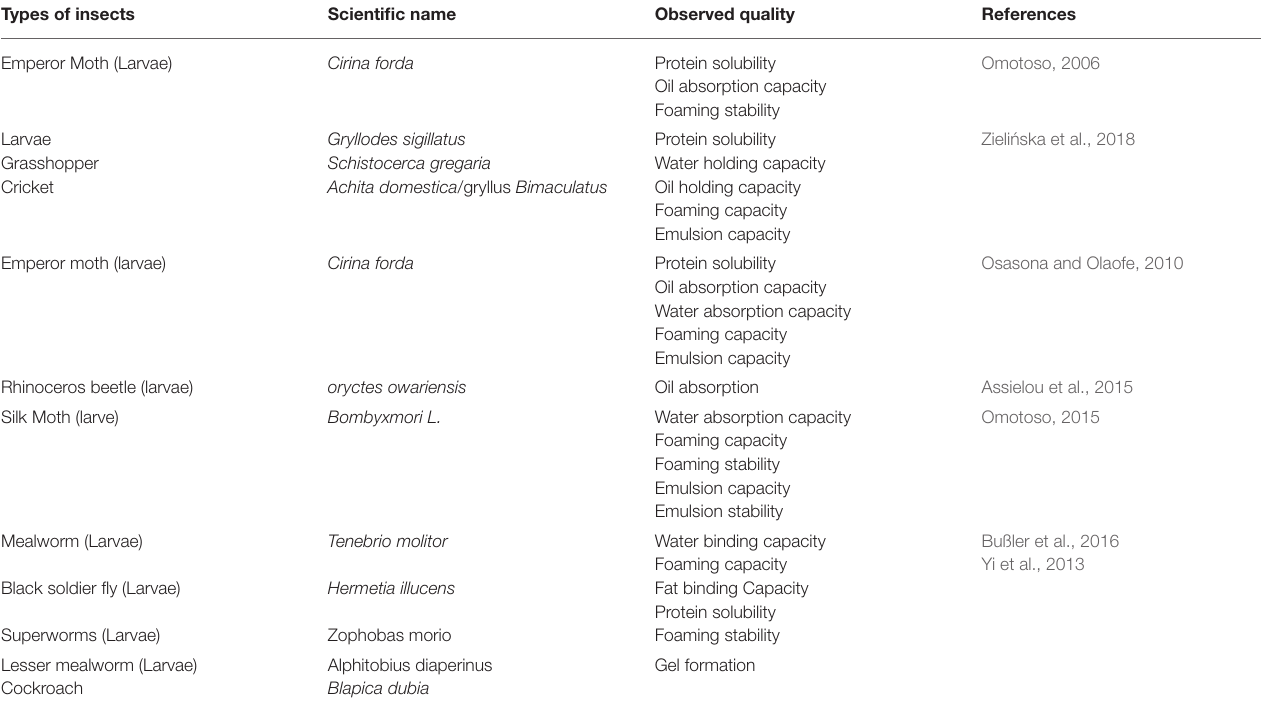
TABLE 1 | Food processing properties of edible insects.